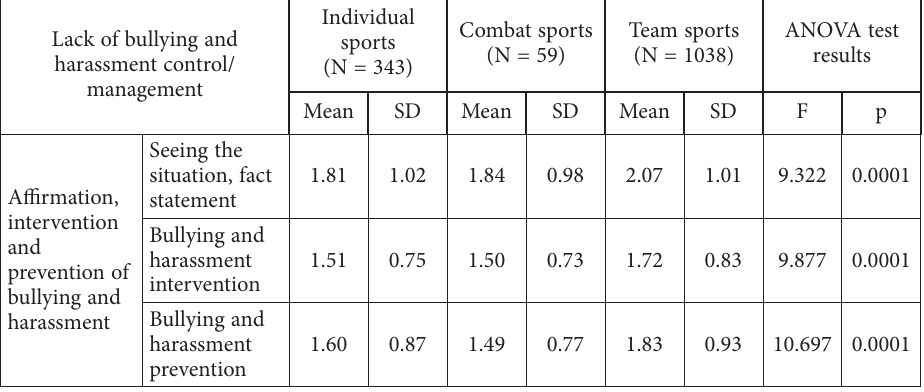
Table 4. Lack of bullying and harassment control/management: individual, combat, team sports types Lack of bullying and harassment